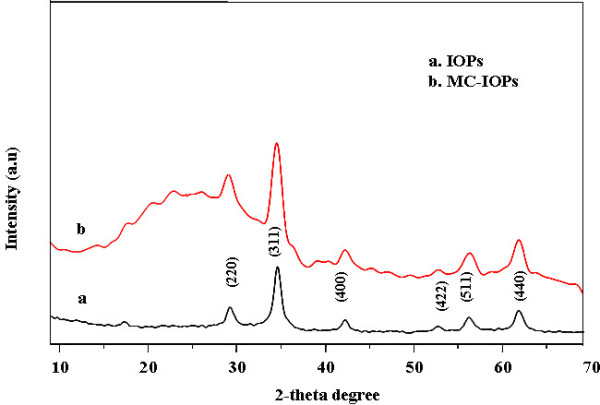
XRD pattern of (a) IOPs, (b) MC-IOPs showing only magnetite reflection.